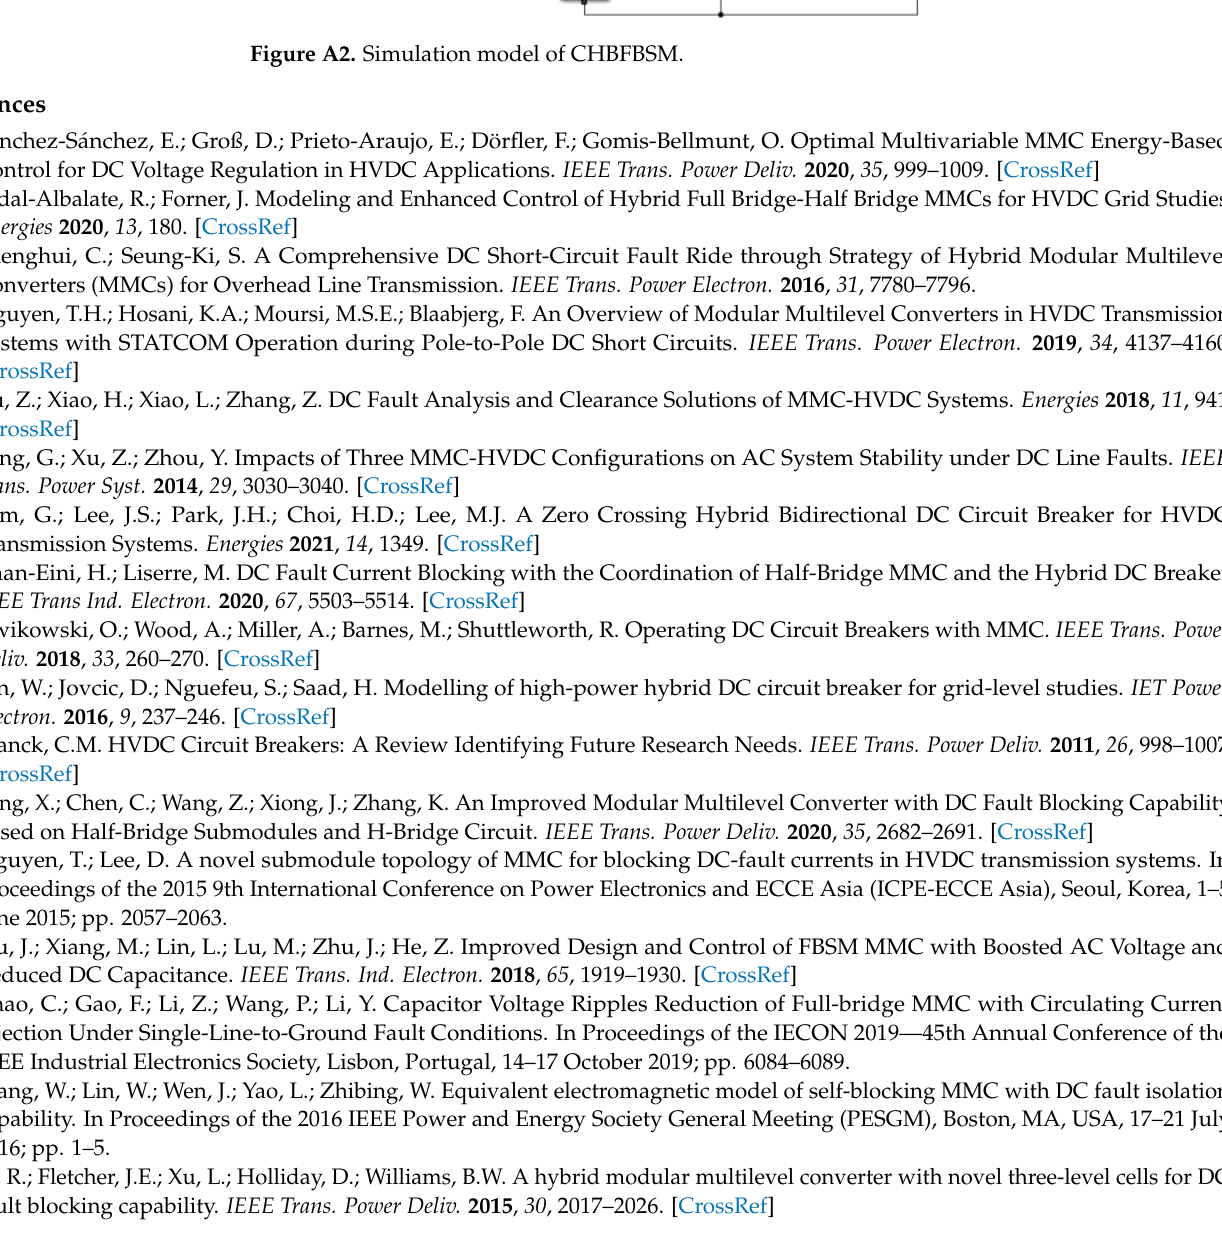
Figure A2. Simulation model of CHBFBSM.